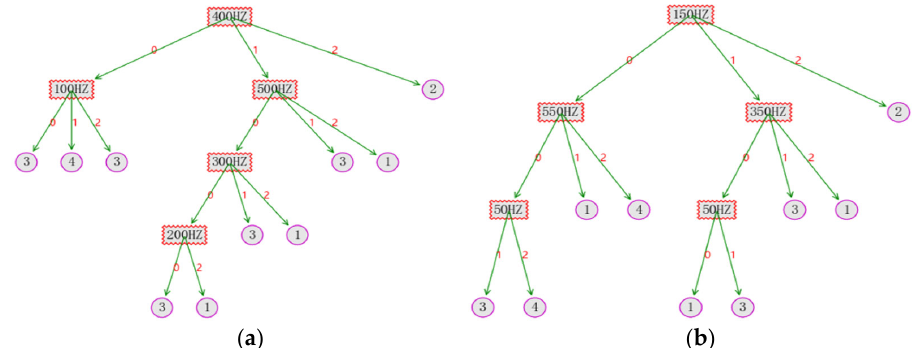
Figure 8. Vibration spectrum decision tree model: ( a ) Even times; ( b ) Odd times.